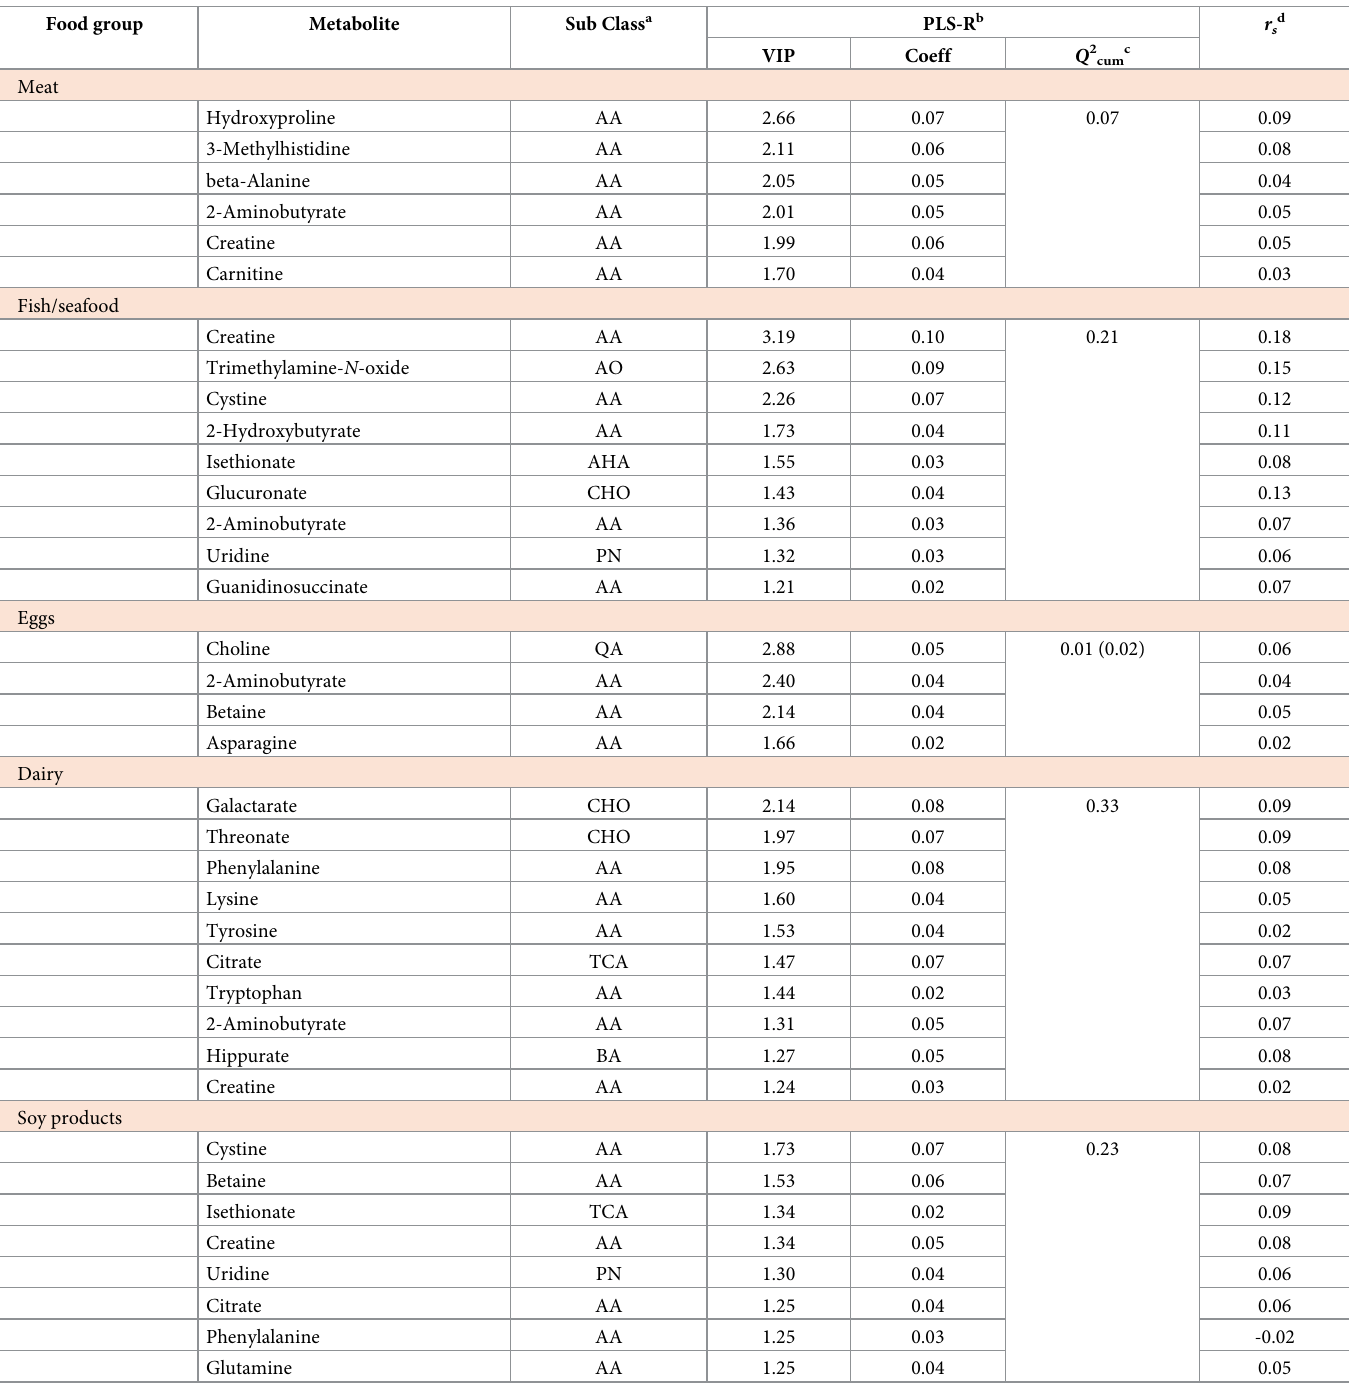
Table 3. Promising food biomarker candidates (n =